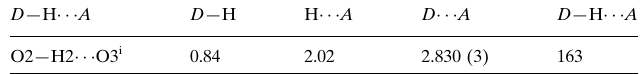
Hydrogen-bond geometry (A˚ , (cid:2)